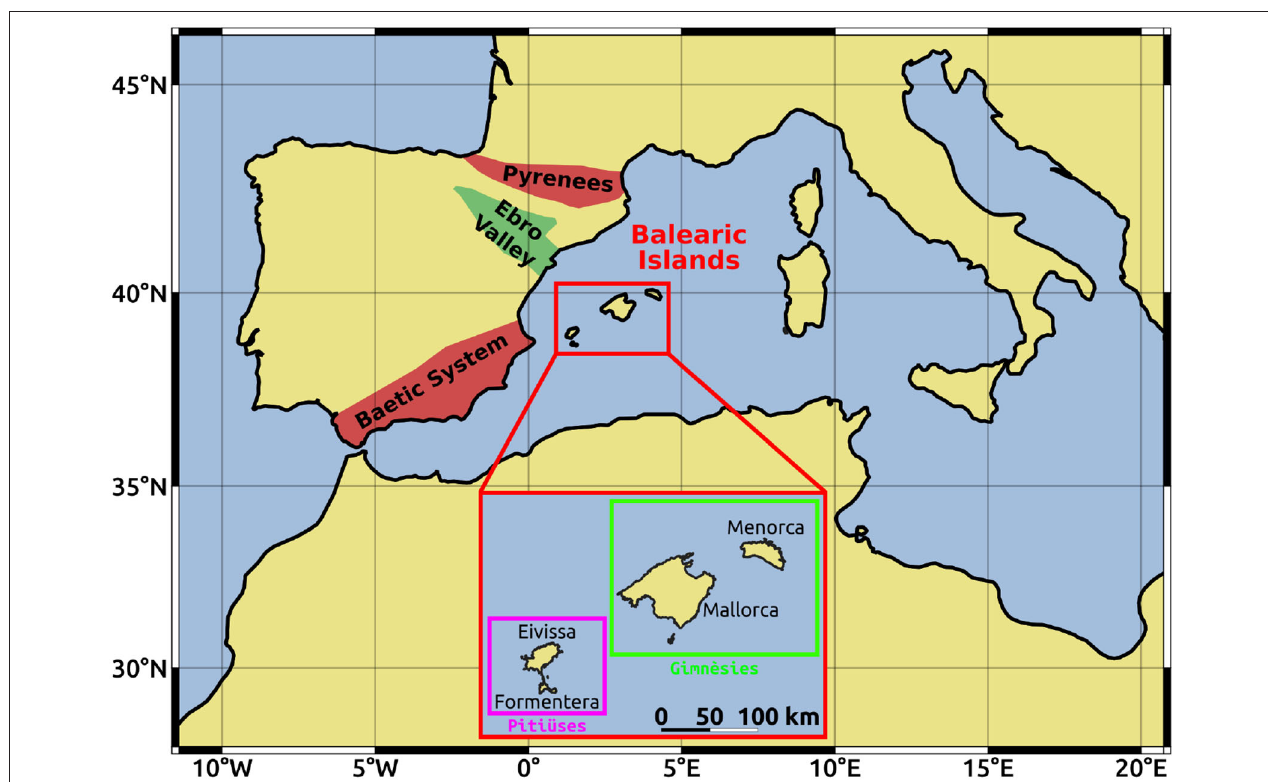
FIGURE 1 | Map of the Western Mediterranean with some geographical features are highlighted. Inset showing the structure of the Balearic Islands. Made with Natural Earth and Open Street Map, © OpenStreetMap contributors.